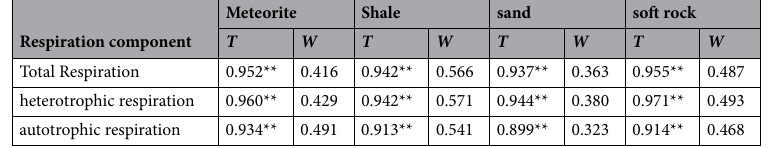
Table 3. Correlation between soil respiration and soil temperature (T), water content (W). **, p < 0.01*, p < 0.05.